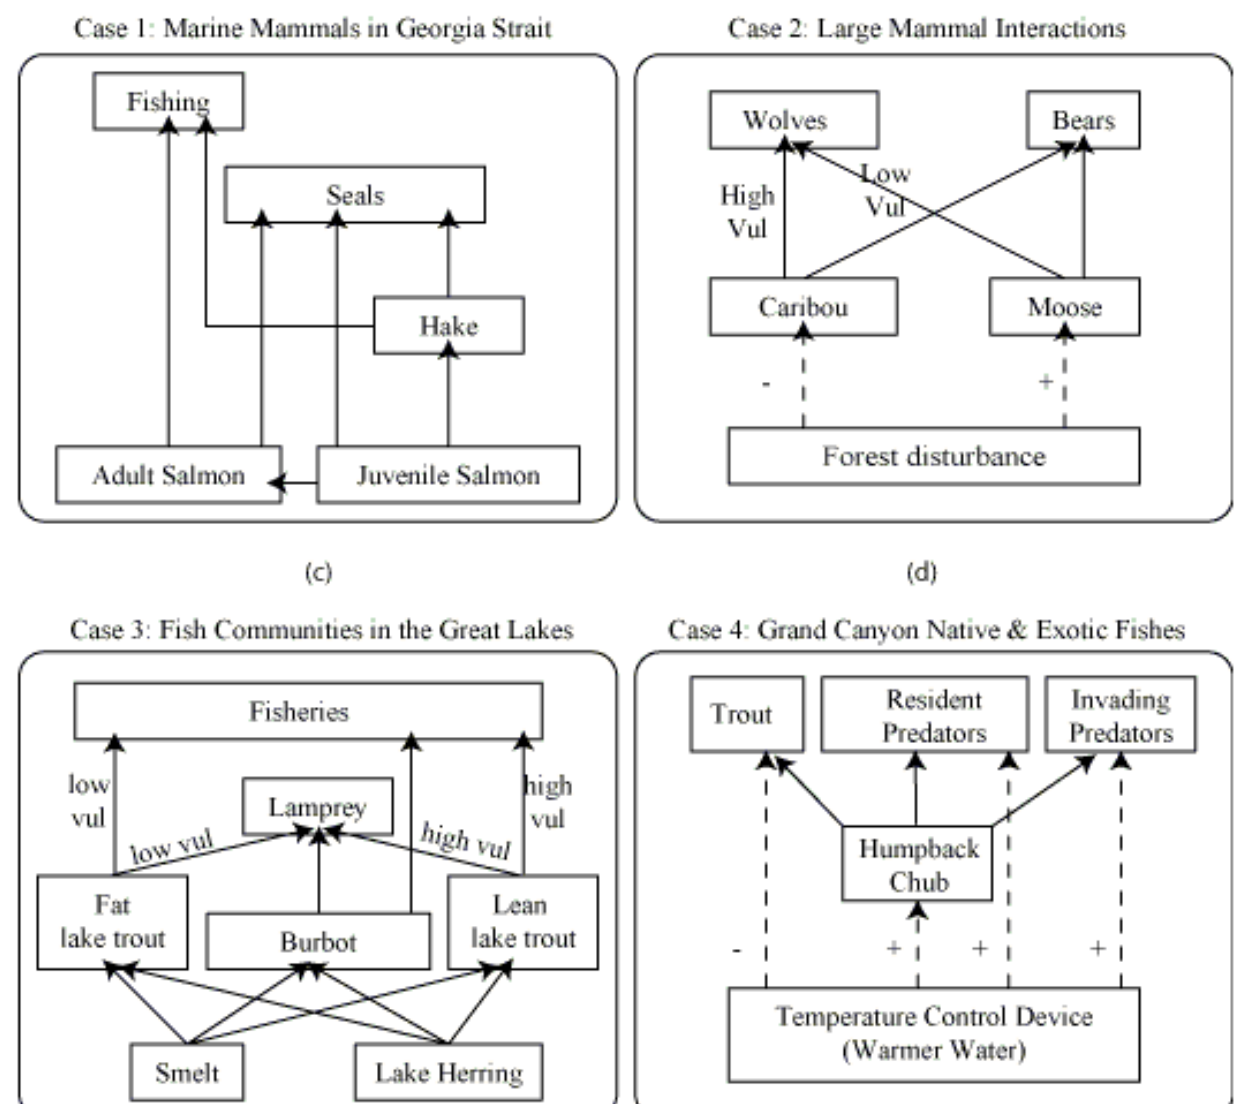
Fig. 1. Graphical representation of interactions between predators, prey, competitors, and human alteration. Solid arrows represent the direction of energy flow. Dashed arrows represent indirect effects on species abundances (positive and negative effects as indicated). (Vul =